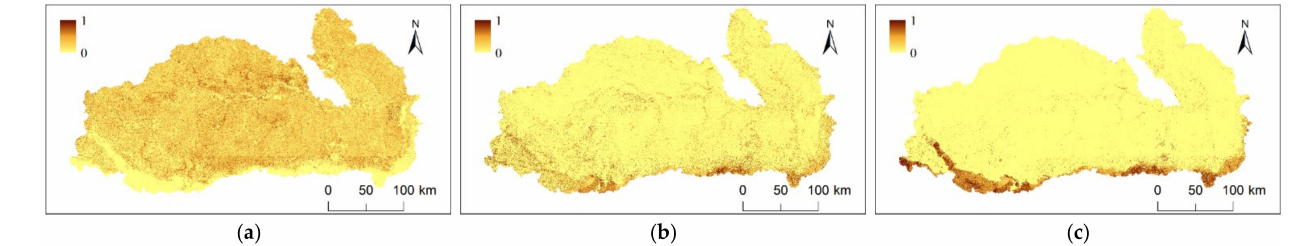
Figure 14. The inferred probability (posterior probability) for three classes of PBF in the Mun River Basin: ( a ) Paddy Rice, ( b ) Deciduous Forest, and ( c ) Evergreen